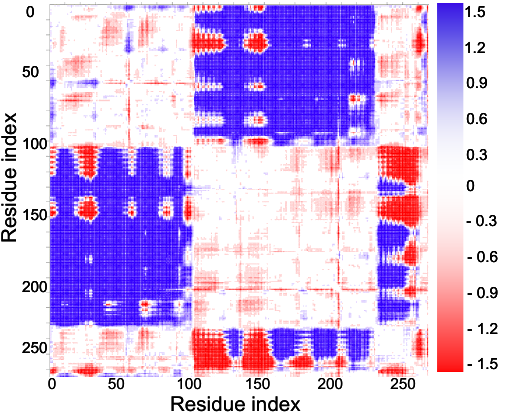
Figure 6. The difference-distance plot of the protein. The color changes from blue to red gradually correspond to the decrease of the distance change, as shown in the color bar on the right of the map. Both X-axis and Y-axis of the map are residue